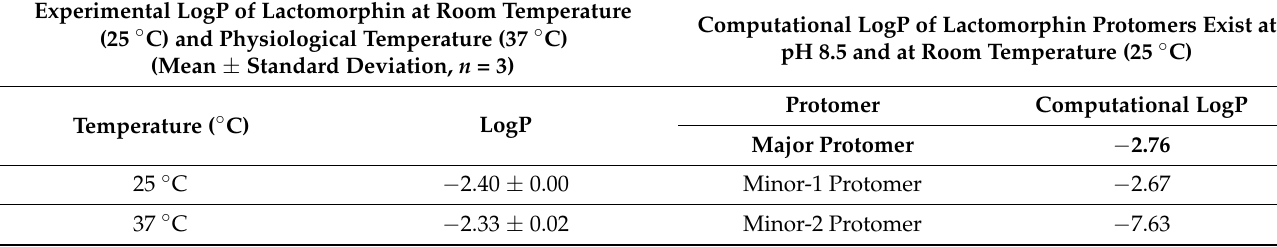
Table 8. Experimental and Computational LogP of